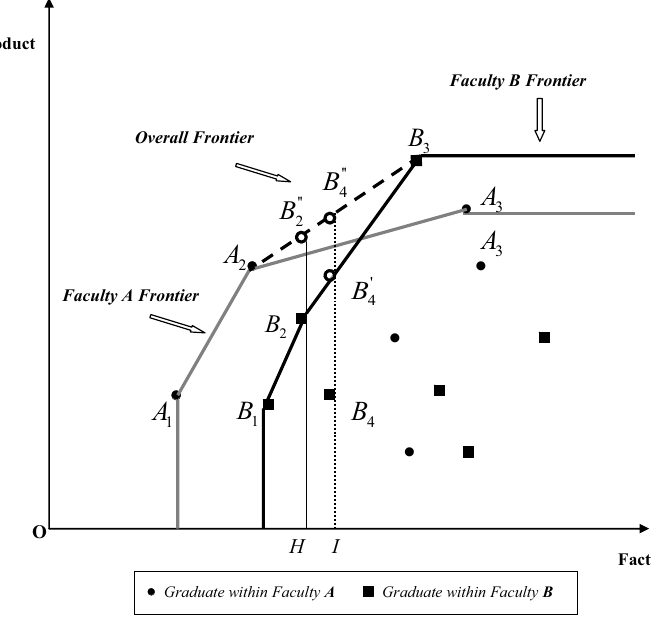
Fig. 1 – Overall and within frontiers under the hypothesis of variable returns to